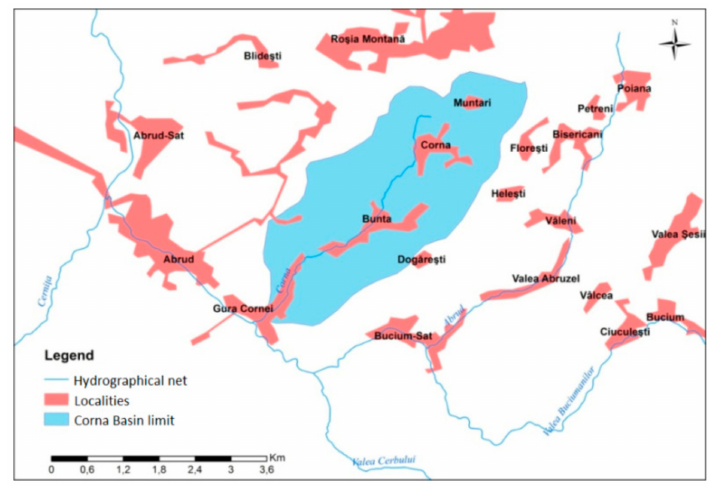
Figure 4. Localities of the Corna Valley and the neighboring areas.